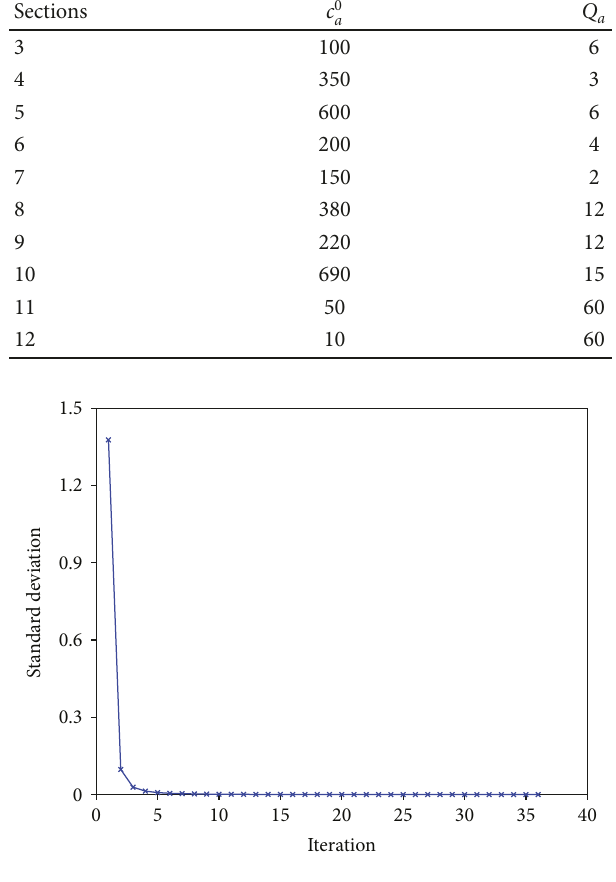
Figure 5: Iterative process.